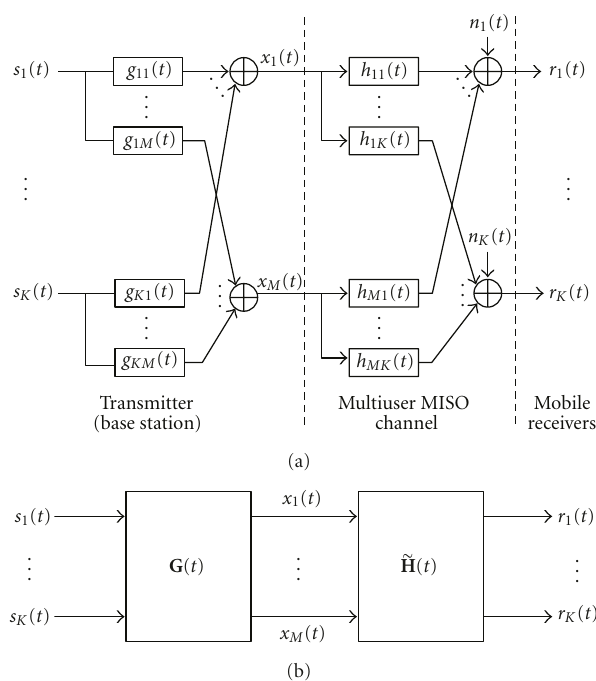
Figure 1: Schematic block diagram of a prefiltering-based MISO UWB communication